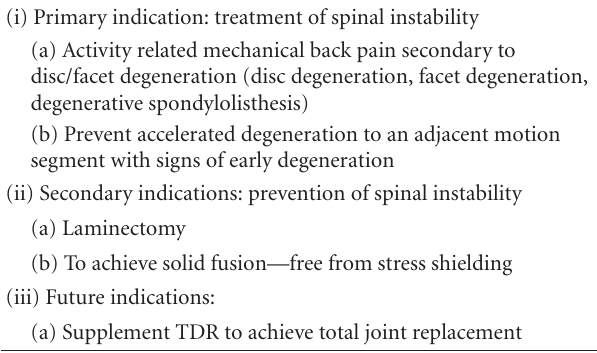
Table 2: Indications for posterior dynamic